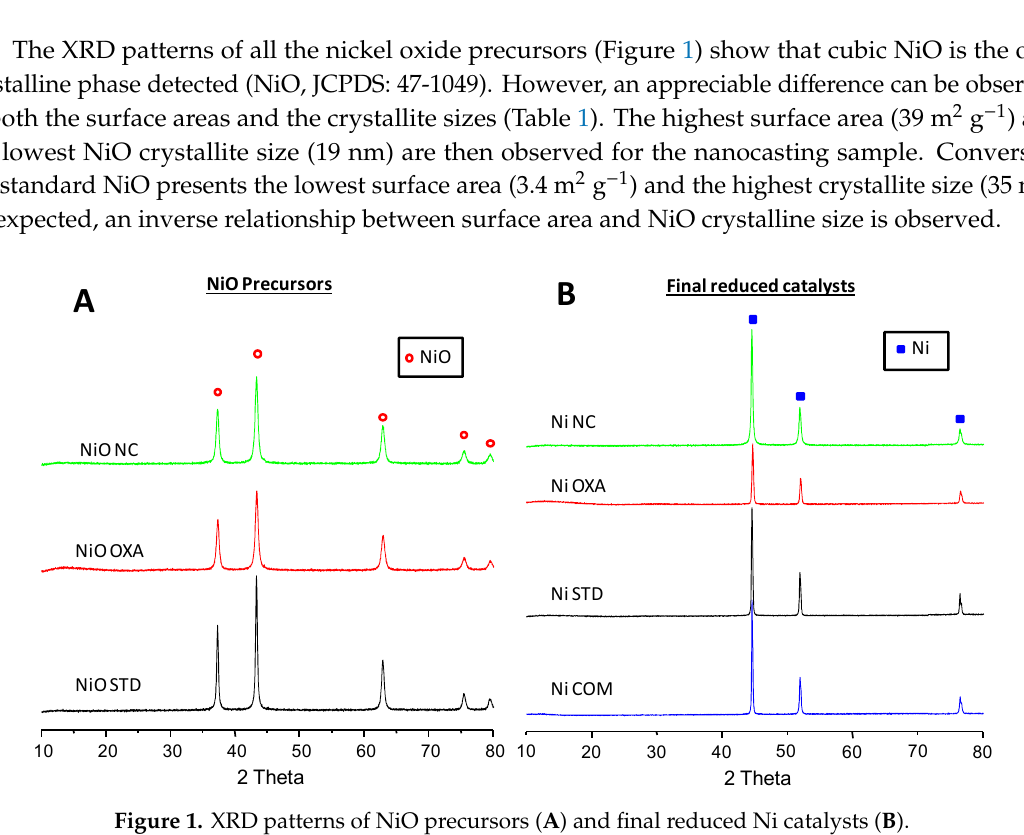
Figure 1. XRD patterns of NiO precursors ( A ) and final reduced Ni catalysts ( B ).